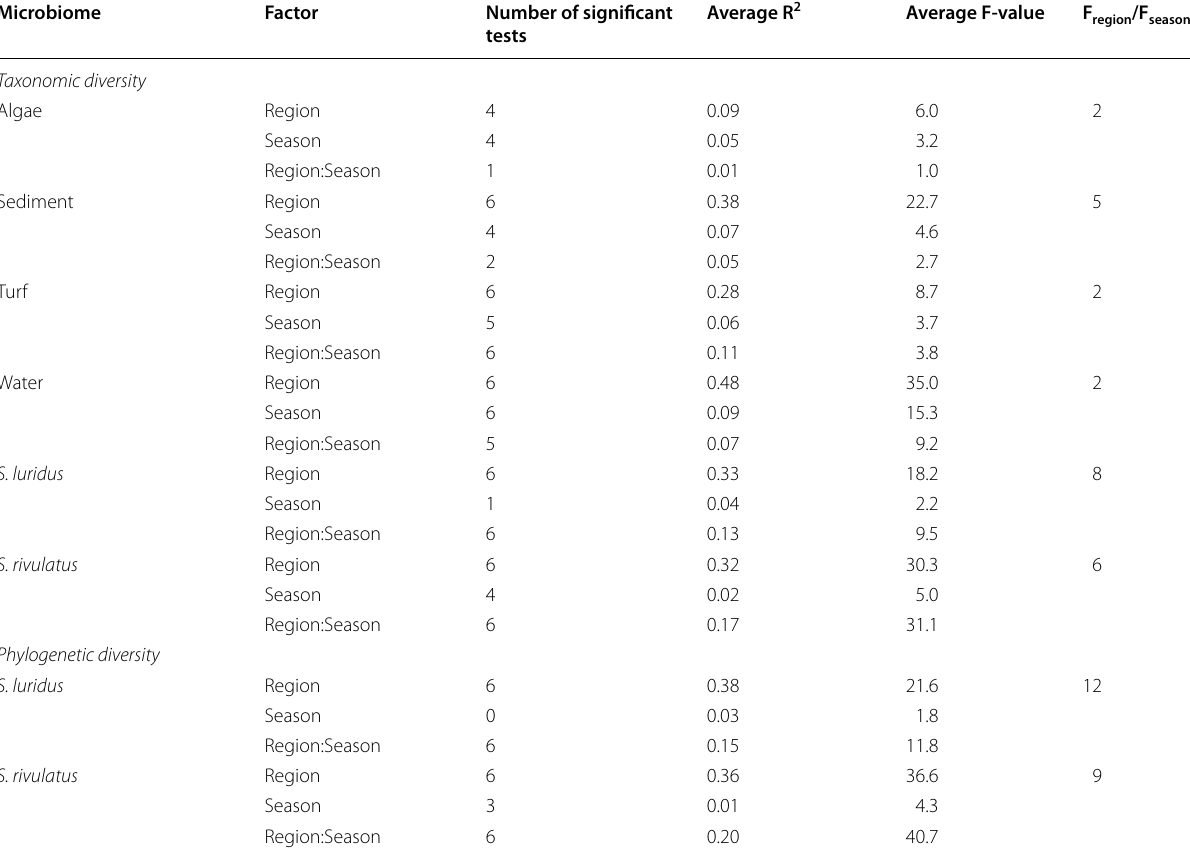
PERMANOVA tests were performed only for the microbiome types for which were sampled for at least two regions and two seasons (Region:Season corresponds to the effect of the interaction). The reported values correspond to averages of tests results performed across three taxonomic ranks (Phylum, Family and ASV) for taxonomic and phylogenetic dissimilarity, estimated with presence-absence or relative abundances data (i.e. q summarizing all the performed PERMANOVA (all combinations of dissimilarity indices and taxonomic ranks) is provided in additional file (Additional file 1: Table S13)